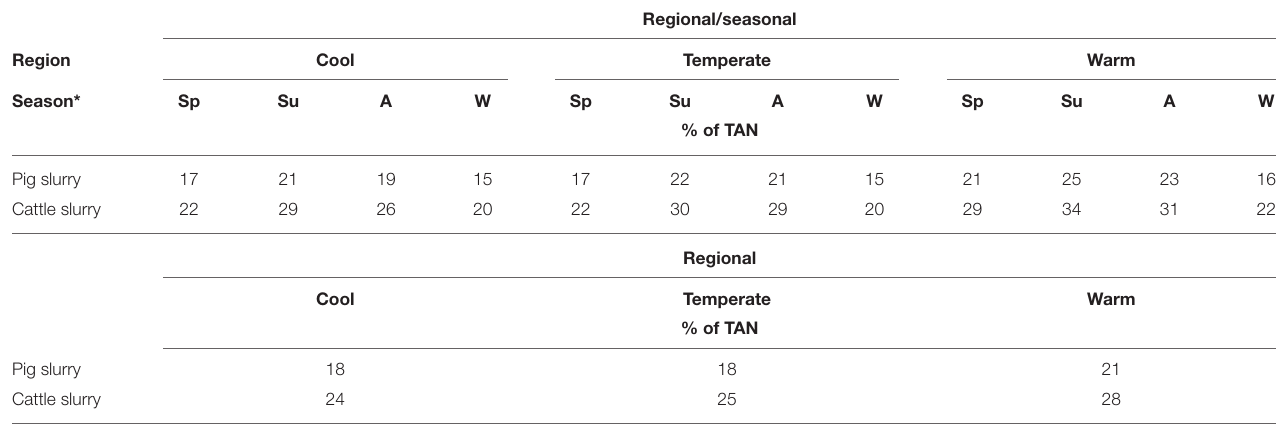
Regional/seasonal